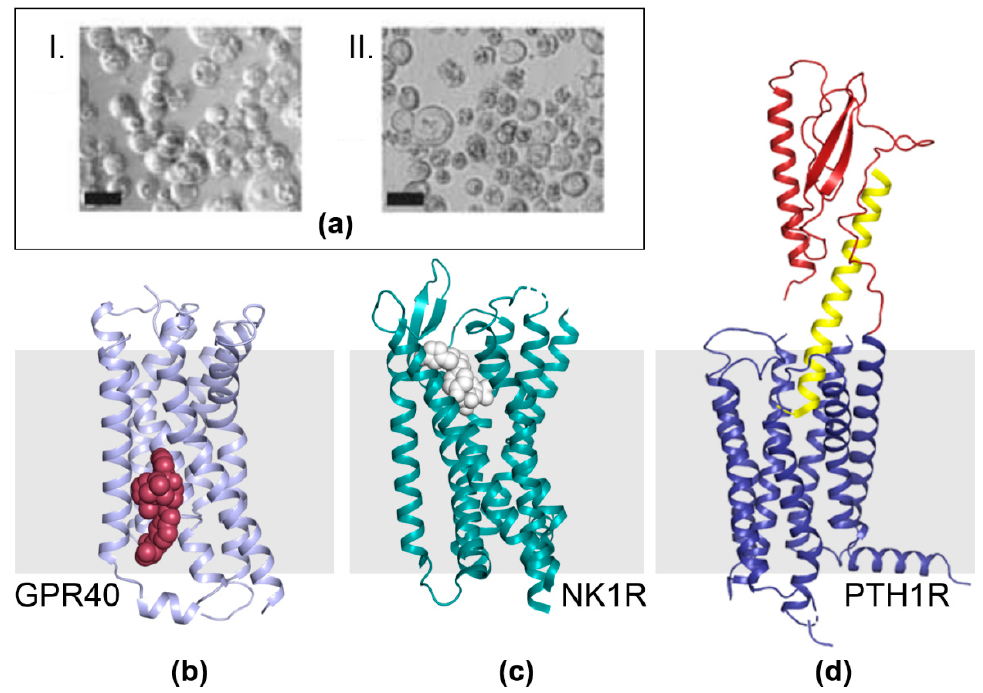
Figure 4. GPCRs made by MultiBac. ( a ) Micrographs show cells 72 h after infection with MultiBac and, for comparison, a commercial competitor baculovirus (Bac-to-Bac, Invitrogen), respectively [12,14]. MultiBac-infected insect cells (I.) are uniformly round and appear intact in contrast to the cell lysis prevalent for Bac-to-Bac infected cells (II.). The elimination of proteolytic and apoptotic factors from the MultiBac backbone significantly improved the integrity of membrane bilayers of infected insect cells at very late stages of the viral life cycle. Scale bars, 20 μ m. ( b – d ) GPCRs were produced by using the MultiBac BICS and crystallized. X-ray structures of ligand-bound free fatty acid receptor GPR40 (violet) bound to a proprietary ligand (compound 1, red) [70] ( b ), neurokinin 1 receptor NK1R (green) bound to ligand aprepitant (white) [71] ( c ) and parathyroid hormone 1 receptor PTH1R (blue and red) bound to peptide ligand ePTH (yellow) [69] ( d ) are shown. The membrane bilayer is depicted schematically (grey bar).